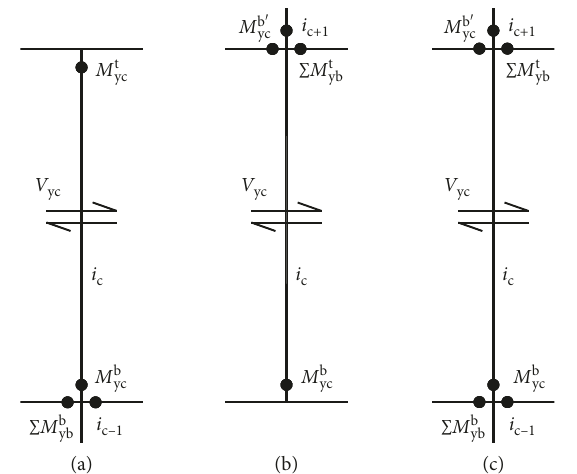
Figure 12: Method of plastic hinge at the column bottom: (a) top layer, (b) bottom layer, and (c) middle layer.